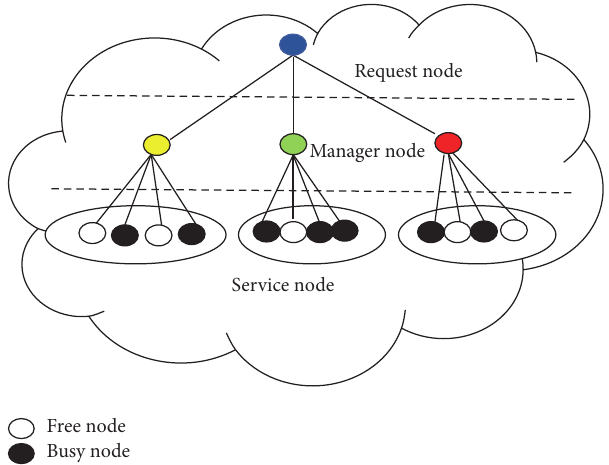
Figure 3: Cloud computing networks